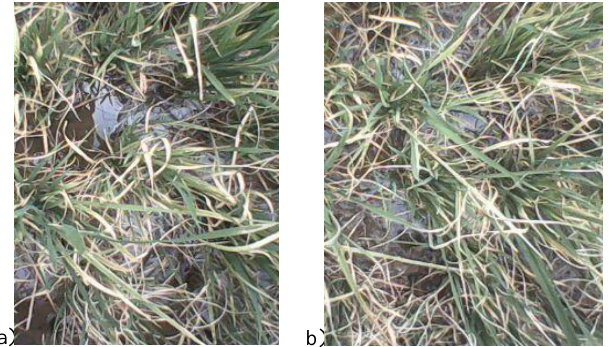
Figure 8: Rice samples; a) control, b) test. Images were taken